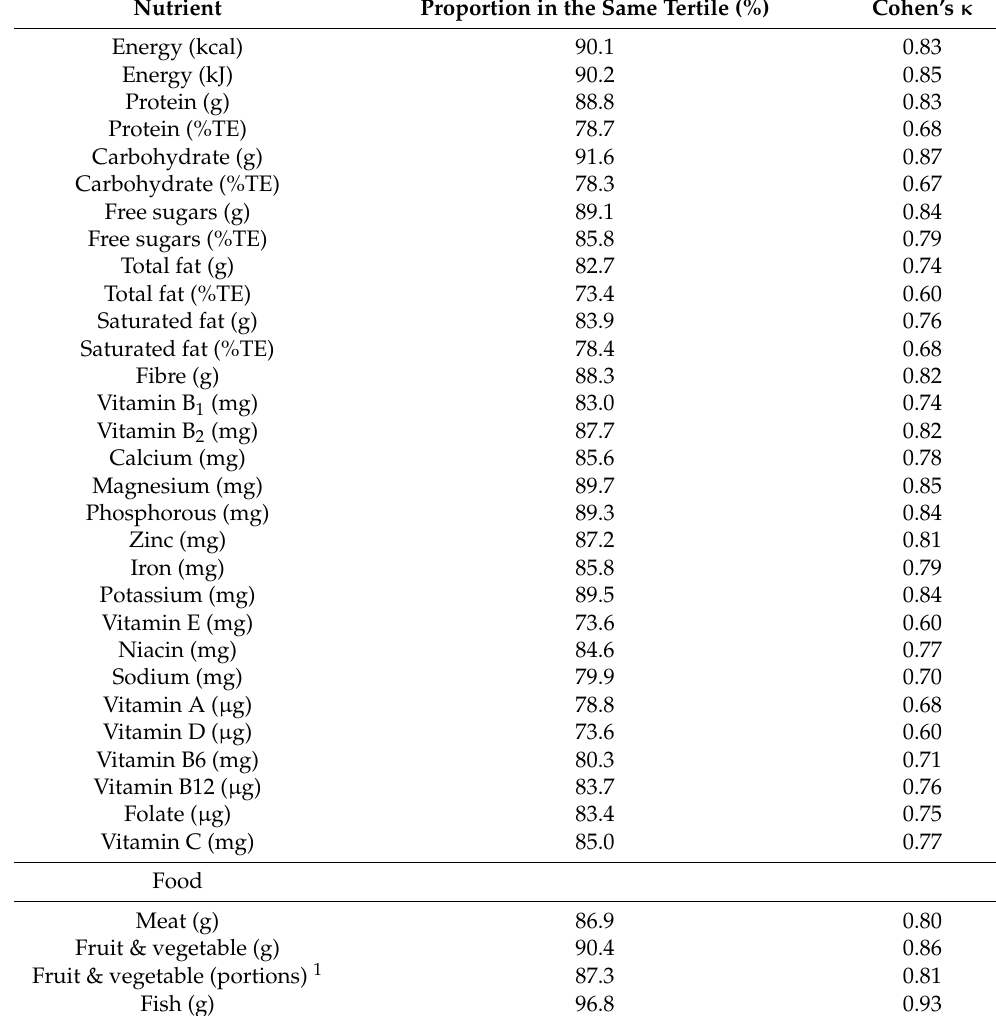
Table 3. Association between estimates of energy, nutrients and selected food intakes from food sources (excluding nutritional supplements) in NDNS year 2017 respondents ( n = 1211)